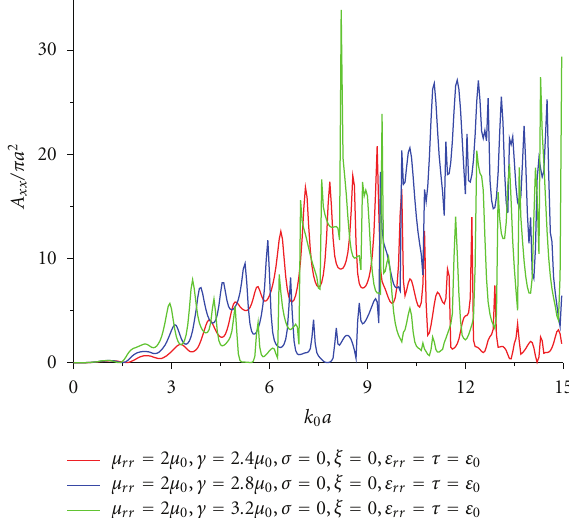
Figure 4: Normalized backscattering values versus sphere radius. Di ff erent negative anisotropic value influence is considered. Here, we increase the negative